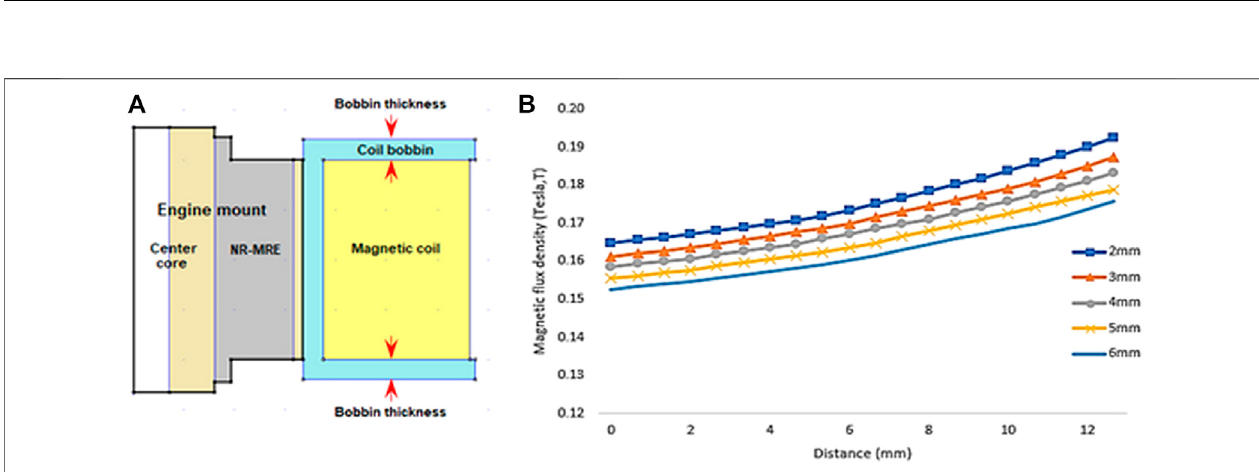
FIGURE 6 | (A) Schematic representation of the coil bobbin thickness; (B) Magnetic density analysis on the coil bobbin thickness.